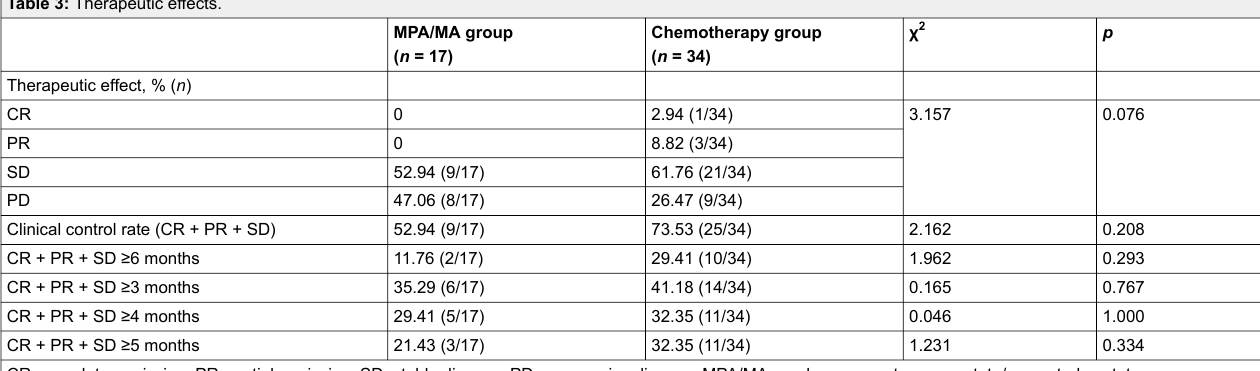
Table 3: Therapeutic effects.